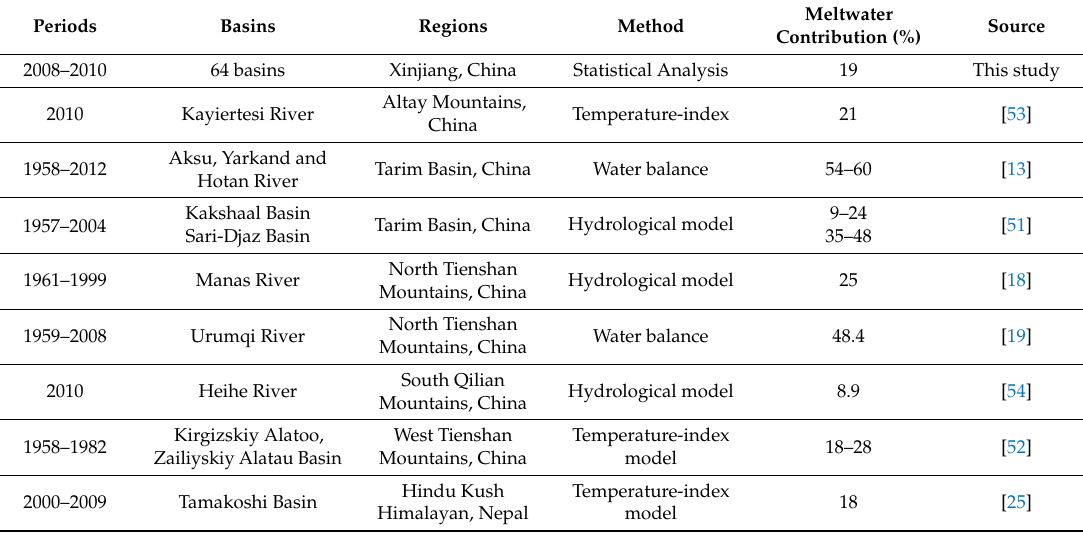
Table 3. Comparison of snowmelt contribution among similar regions in